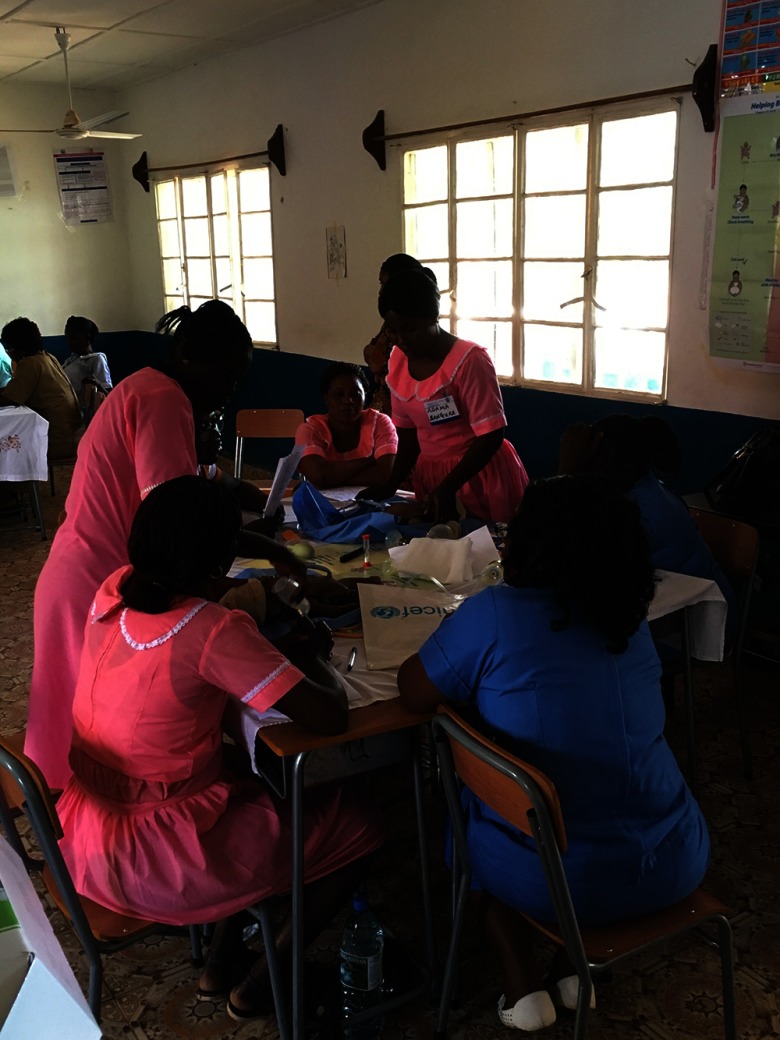
Field testing of Helping Babies Breathe 2nd Edition with MNCH aides in Kabala, Sierra Leone. © 2016 Erick Amick/American Academy of Pediatrics.